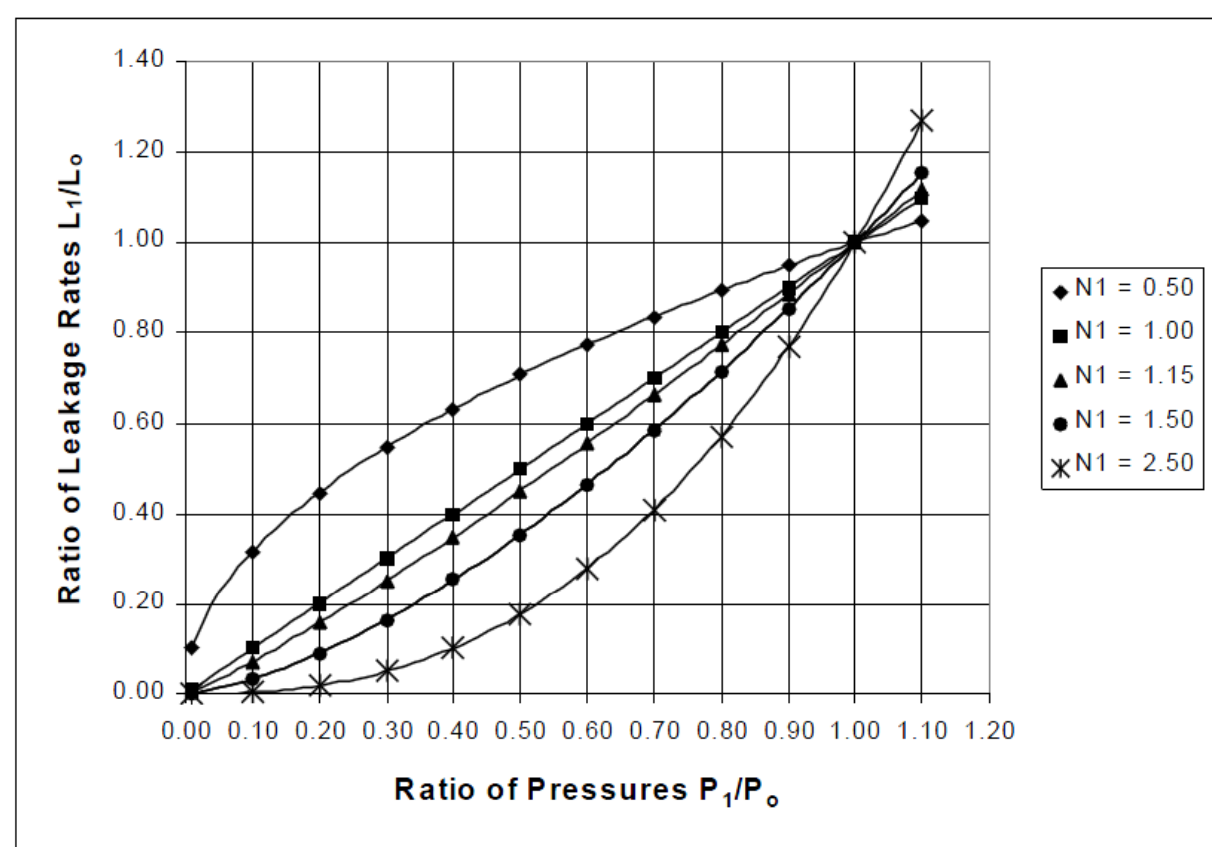
Figure 1. General relationship between pressure and leakage via N1 [7].